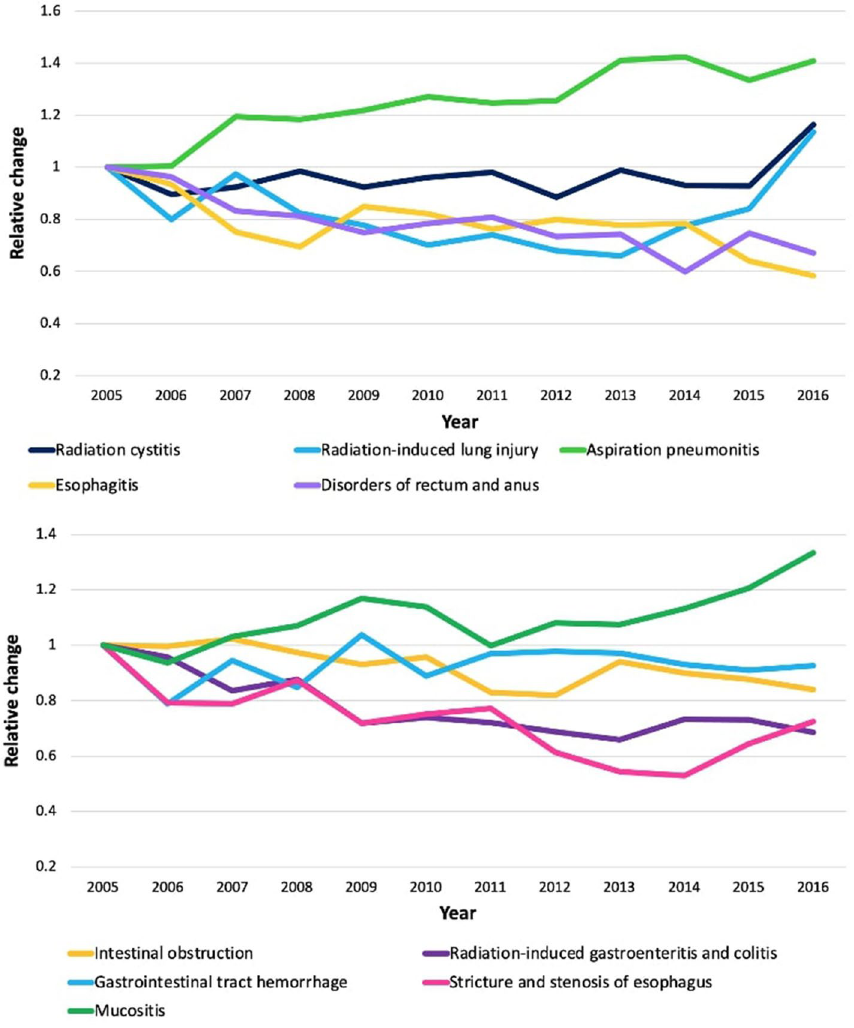
Figure 2. Relative change in number of hospitalizations for radiation cystitis, radiation-induced lung injury, aspiration pneumonitis, esophagitis, and disorders of rectum and anus, intestinal obstruction,